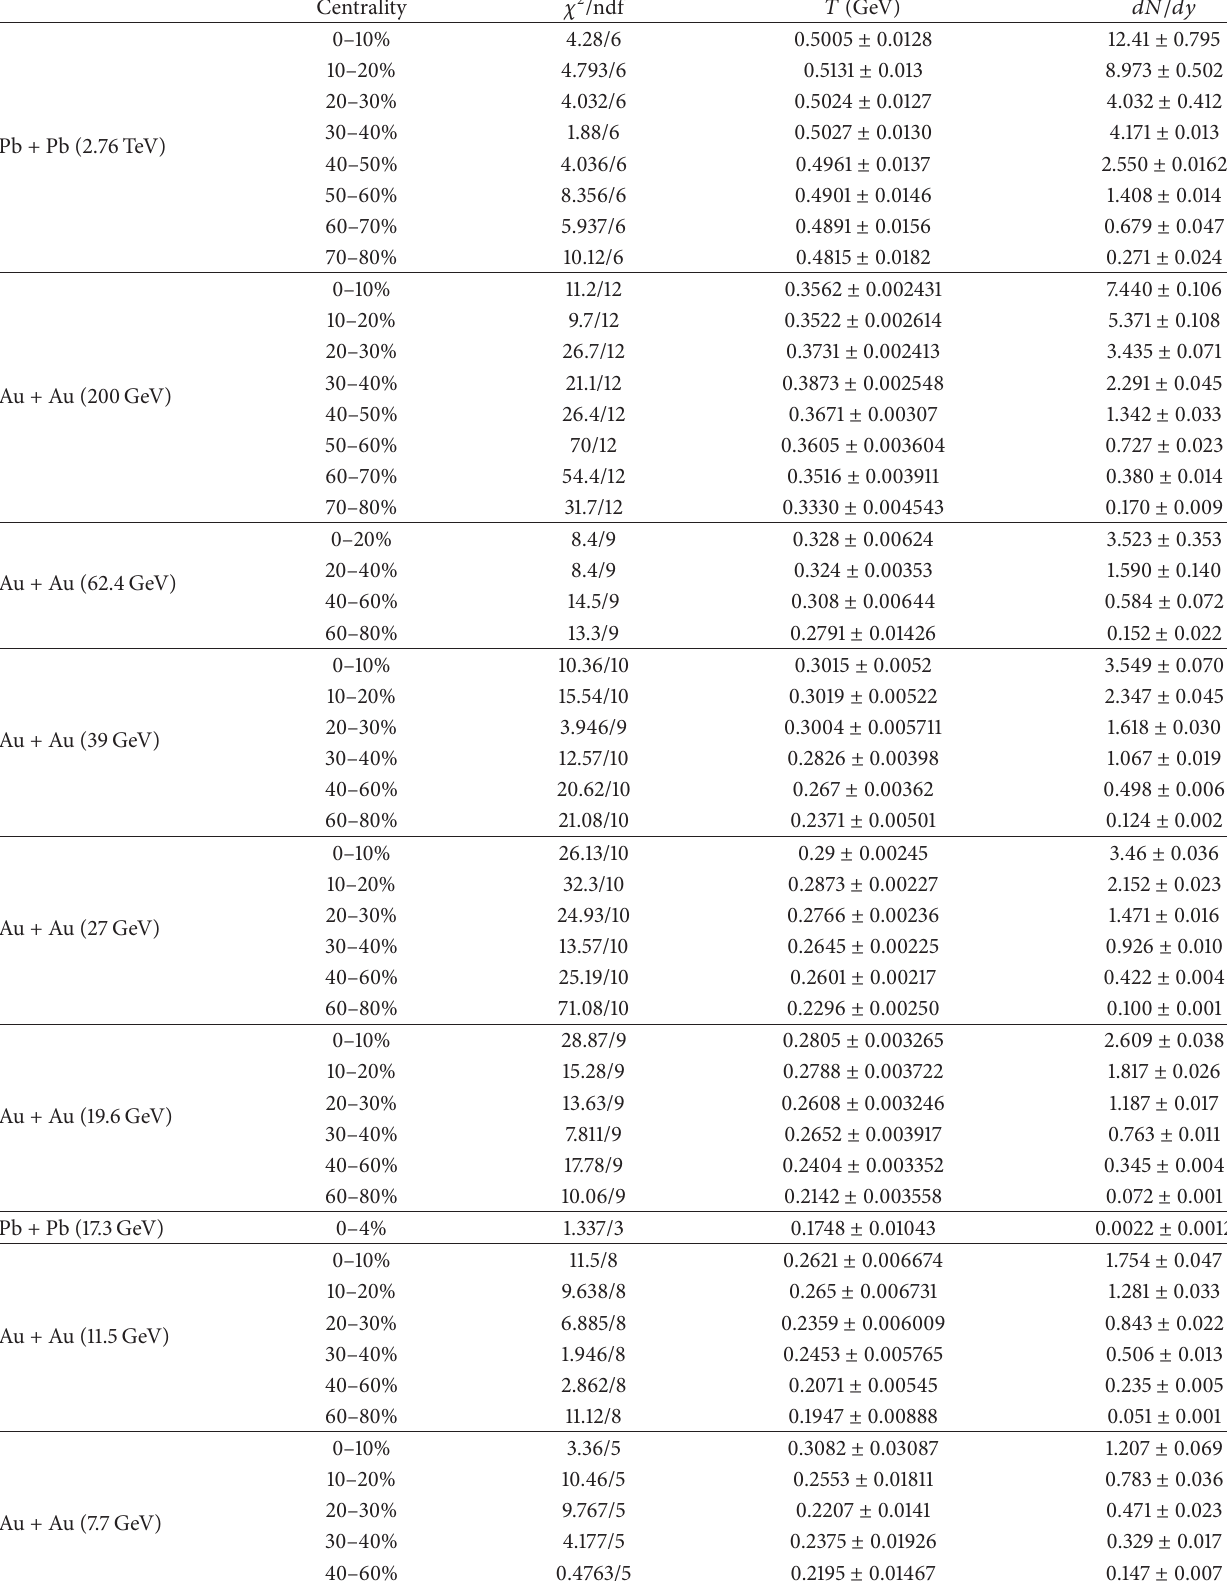
Table 2: Results from exponential fits to the transverse mass distributions of the 𝜙 meson. All values are for midrapidity ( |𝑦| < 0.5 ).